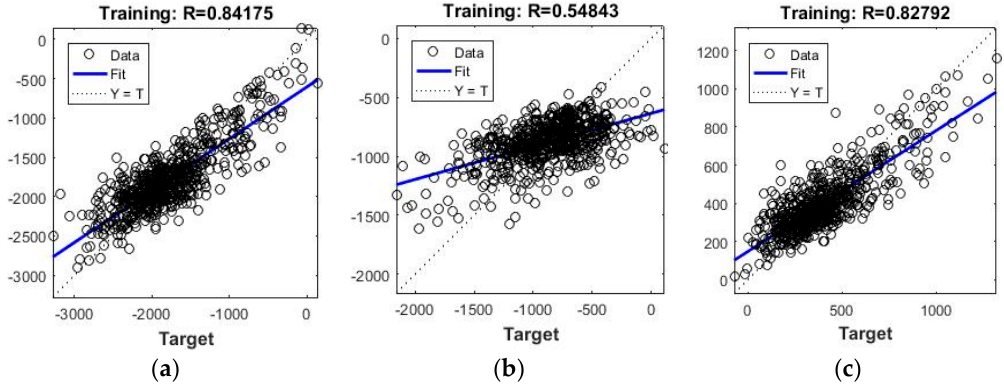
Figure 9. BNN 10 hidden layers fitting results based on the 85% of the samples: ( a ) Group of multispectral bands, multispectral and hyperspectral vegetation indices against GPR slice depth between 0.00–0.20 m; ( b ) Group of multispectral bands, multispectral and hyperspectral vegetation indices against GPR slice depth between 0.20–0.40 m; and ( c ) Group of multispectral bands, multispectral and hyperspectral vegetation indices against GPR slice depth between 0.40–0.60 m.